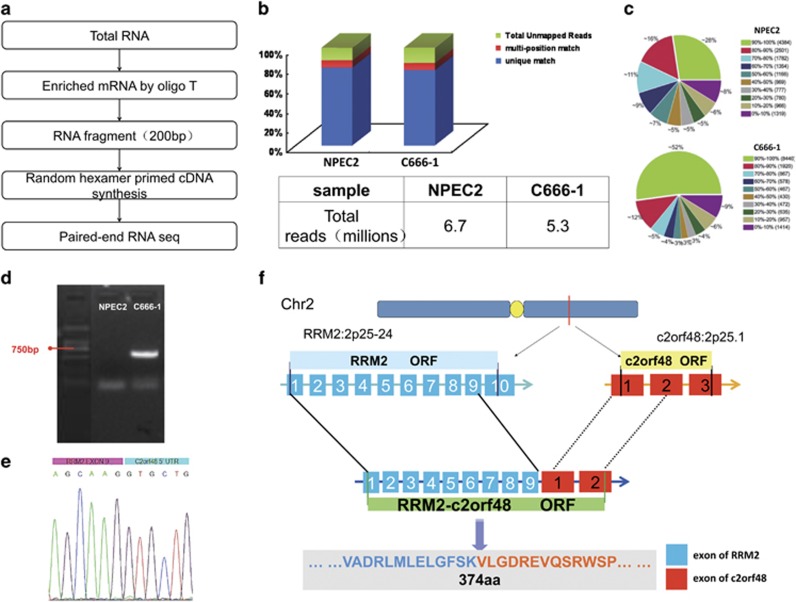
Paired-end RNA-seq data and fusion gene analysis. (a) RNA-seq experiment process. (b) Data statistics and reads comparison between NPEC2 and C666-1; the unique reads ratio of both templates was >80%. (c) The gene coverage results show that the ratio of gene coverage reaching >70% was 55% and 69% in NPEC2 and C666-1, respectively. (d) The representative 1% agarose gel image of the amplification of chimeric transcript RRM2-c2orf48 by templates of cDNA from nasopharyngeal carcinoma cell line C666-1 and nasopharyngeal epithelium NPEC2 cells. The specific PCR product of RRM2-c2orf48 is approximately 600 bp in C666-1 but not in NPEC2. (e) Sequencing results show the chimeric site between RRM2 and c2orf48 at the mRNA level. (f) Formation model of chimeric transcript RRM2-c2orf48: RRM2 is located on chromosome 2p25-24, and c2orf48 is located on 2p25.1. During transcription, read-through occurred between RRM2 exon9 and c2orf48 exon 1. As a result, a new protein with 374 amino acids that was shorter than the wild-type RRM2 was produced (389 amino acids)